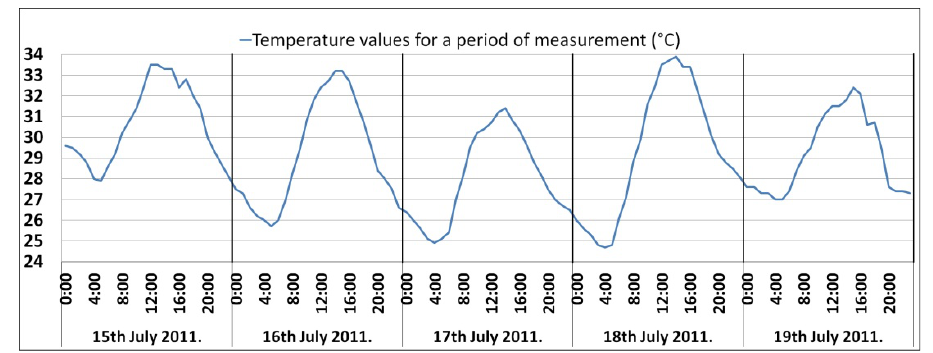
Figure 1. Temperature values for the measurement